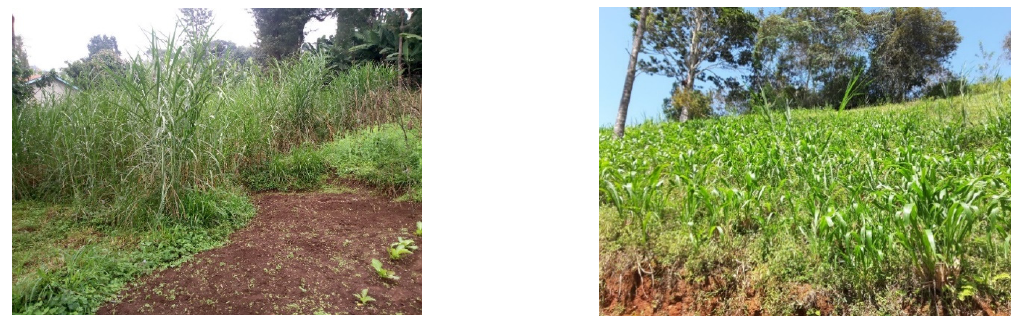
Figure 5. Improved forage production in smallholder dairy cattle farming systems (SHDFS).